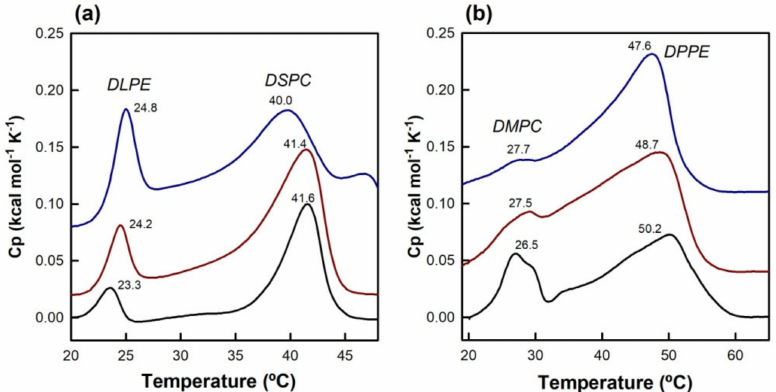
Figure 6. DSC thermograms for systems composed of ( a ) DLPE/DSPC 1:1 and ( b ) DMPC/DPPE 1:1, in the absence and presence of TMX. Black: pure phospholipids; red: +10 mol% TMX; blue: +20 mol% TMX. Total phospholipid concentration was 2 mM, and scanning rate was 4 ◦ C min − 1 . The dashed lines illustrate the procedure used to obtain the transition completion temperatures. Black numbers on the peaks correspond to the T m of the corresponding